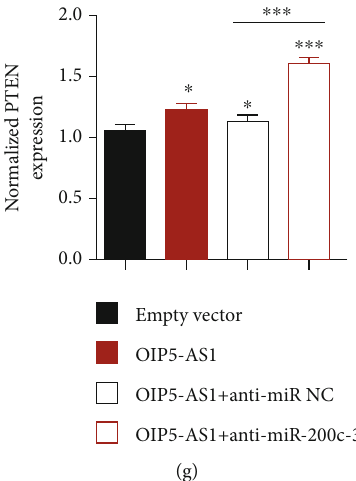
Figure 5: OIP5-AS1 could regulate PTEN ’ s expression via sponging miR-200c-3p. (a) Predictive binding sequence of miR-200c-3p and OIP5-AS1 by starBase 3.0. (b) Dual-luciferase reporter assay showed that miR-200c-3p mimics reduced fl uorescence intensity of OIP5-AS1-WT, while having no in fl uence in OIP5-AS1-Mut. (c) The level of miR-200c-3p was detected using qPCR assay when altering OIP5-AS1. (d) Predictive binding sequence of miR-200c-3p and PTEN by starBase 3.0. (e) Dual-luciferase reporter assay showed that miR-200c-3p could a ff ect PTEN-3 ′ -UTR WT but not PTEN-3 ′ -UTR Mut. (f, g) The transcriptional level of PTEN was measured using a qPCR assay while a ff ecting miR-200c-3p and